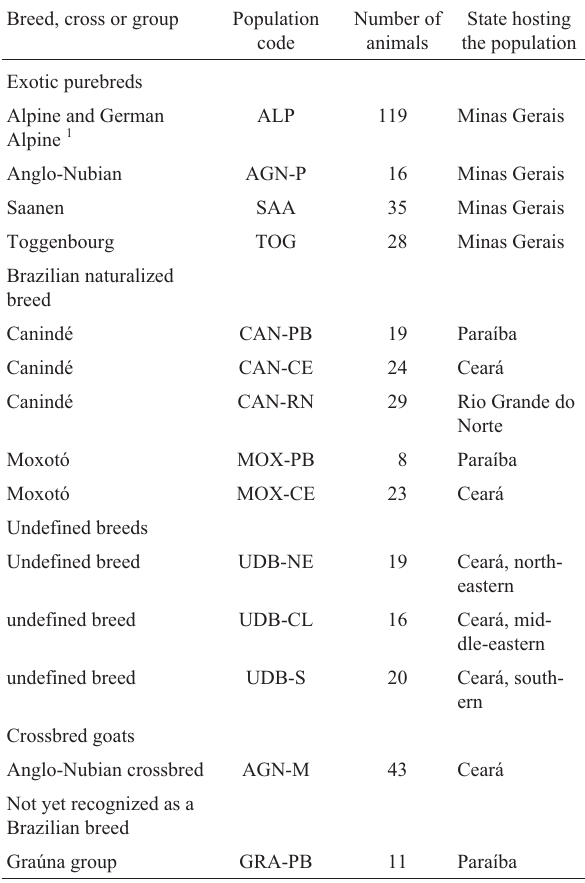
Table 1 - List of the goat populations studied. Breed, cross or